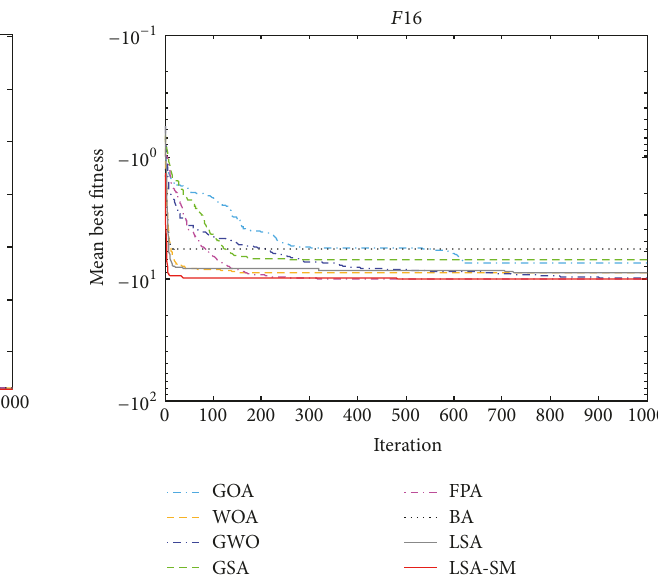
Figure 18: 𝐷 = 3 , convergence curves for 𝑓 14 .